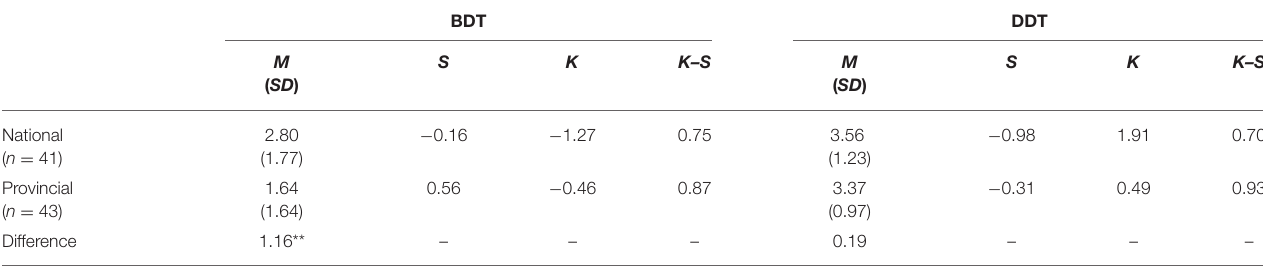
TABLE 2 | Discrimination sensitivity ( d ′ ) in BDT and DDT between the groups.